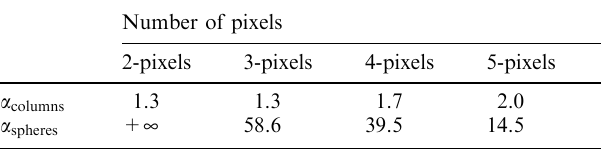
Table 1. Values of (cid:97) for di(cid:128)erent pixel configurations obtained using the numerical